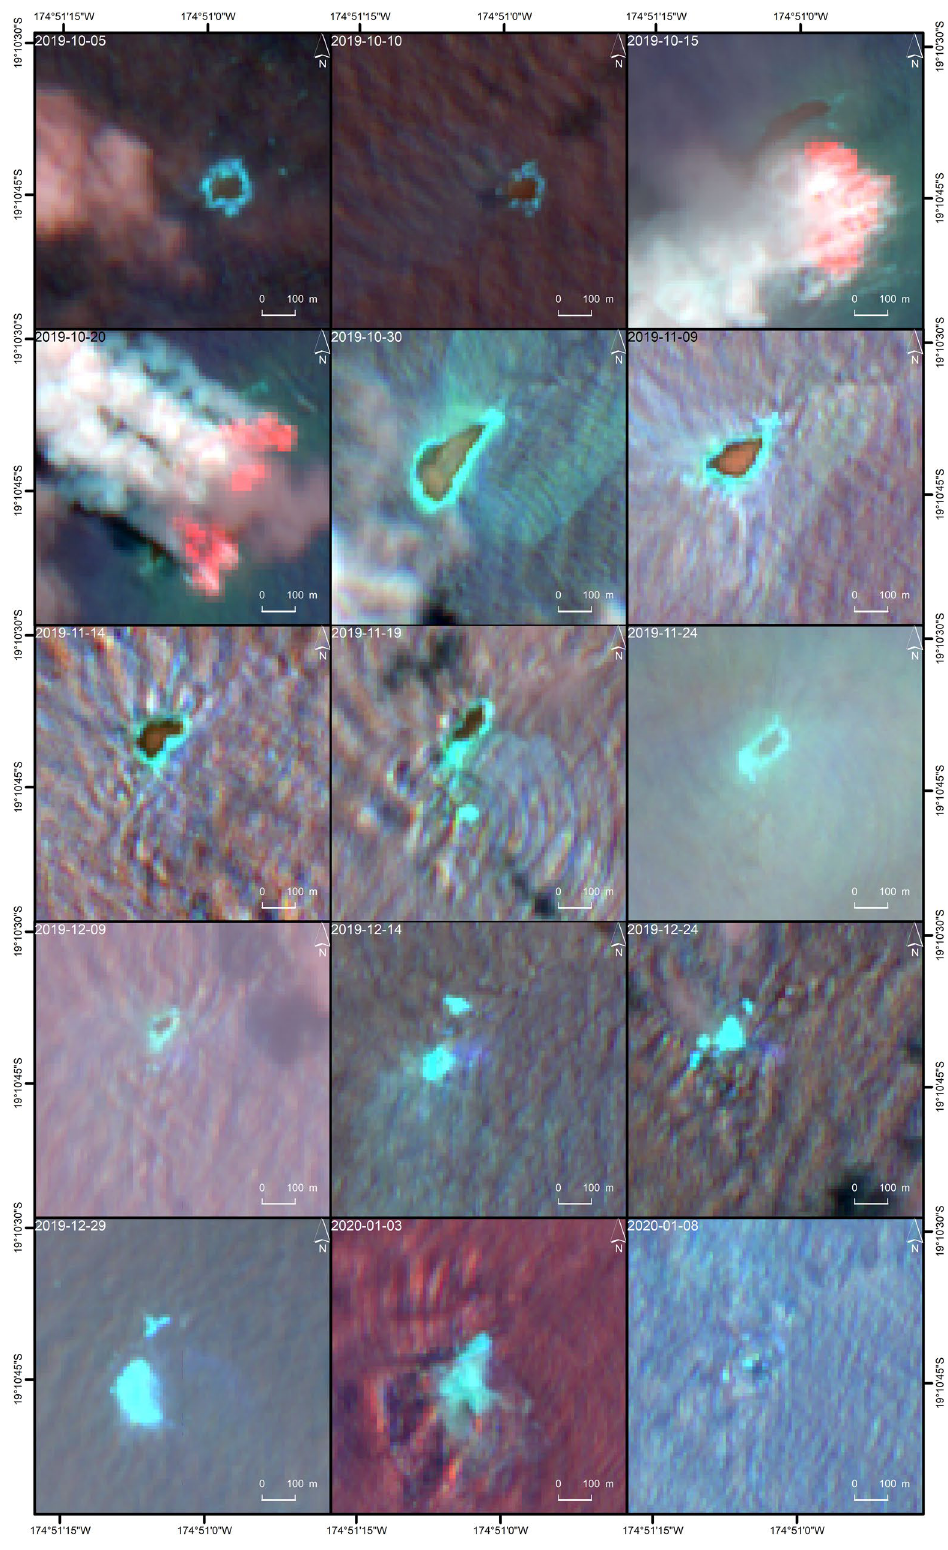
Figure 2. Time series of Sentinel-2 imagery (band combination 12/4/2) over Late’iki Volcano from 5 October 2019 until 8 January 2020. The old Late’iki Island is clearly visible until finally 10 October 2019. The acquisitions of 15 and 20 October 2019 show the ongoing eruption and the birth of New Late’iki Island, which then eroded during the next two months. Background: Sentinel-2 Copernicus data